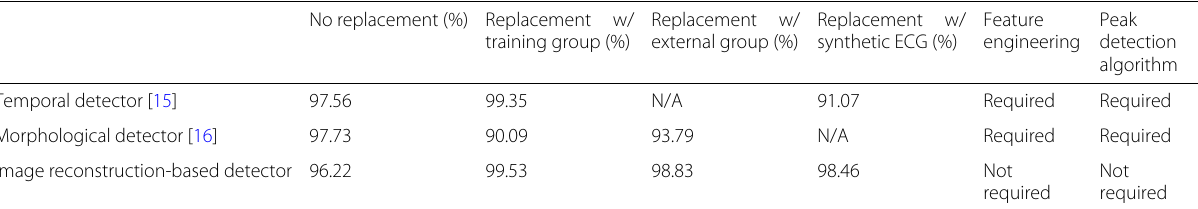
Table 3 Comparison with our previous work for detecting data manipulation attacks on ECG sensor measurements